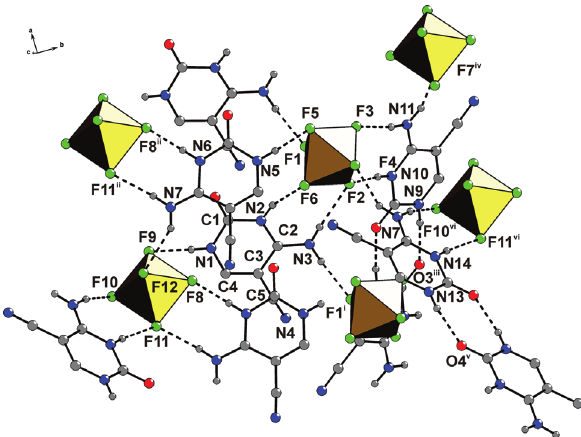
Figure 3. Detail of the crystal packing of 3 and atom numbering scheme. Hydrogen atoms not involved in hydrogen bonding have been omitted for clarity. Symmetry codes: (i) x –1, y , – z ; (ii) x +1, y , z ; (iii) – x , – y +2, – z +2; (iv) x +1, y +1, z ; (v) – x –1, – y +2, – z +1, (vi) x , y +1, z .